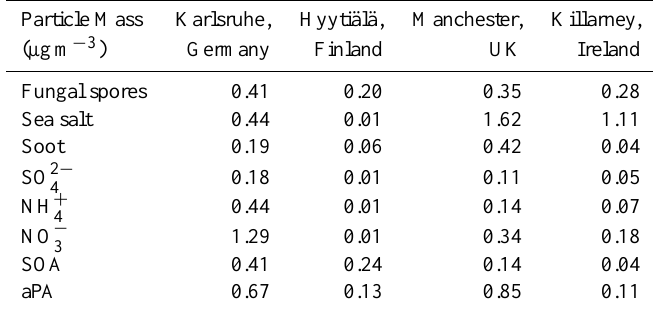
Table 5. Simulated aerosol mass concentrations for aerosol chemical components, including fungal spores, in µgm − 3 at the measuring sites as averages over the time period during August